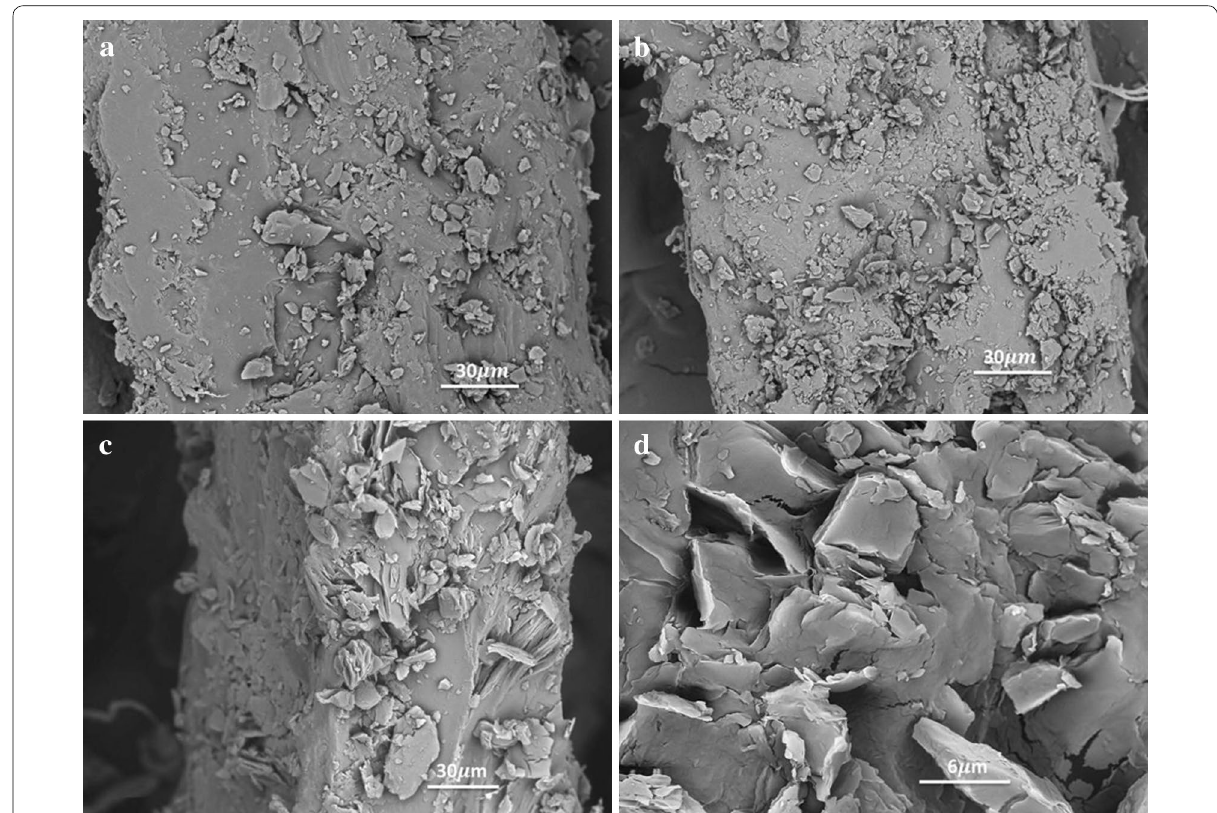
800), b CPCMs‑4 with 3% EG ( ×